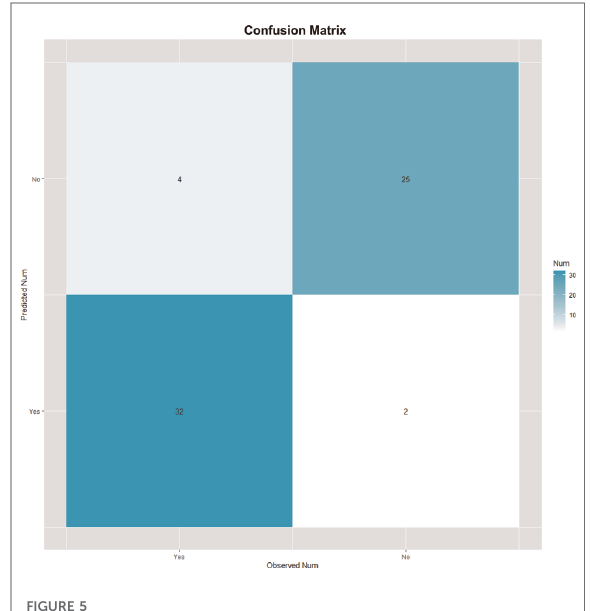
FIGURE 5 Predicted result of the fi nal SVM model for CPSP risk in Set 1.